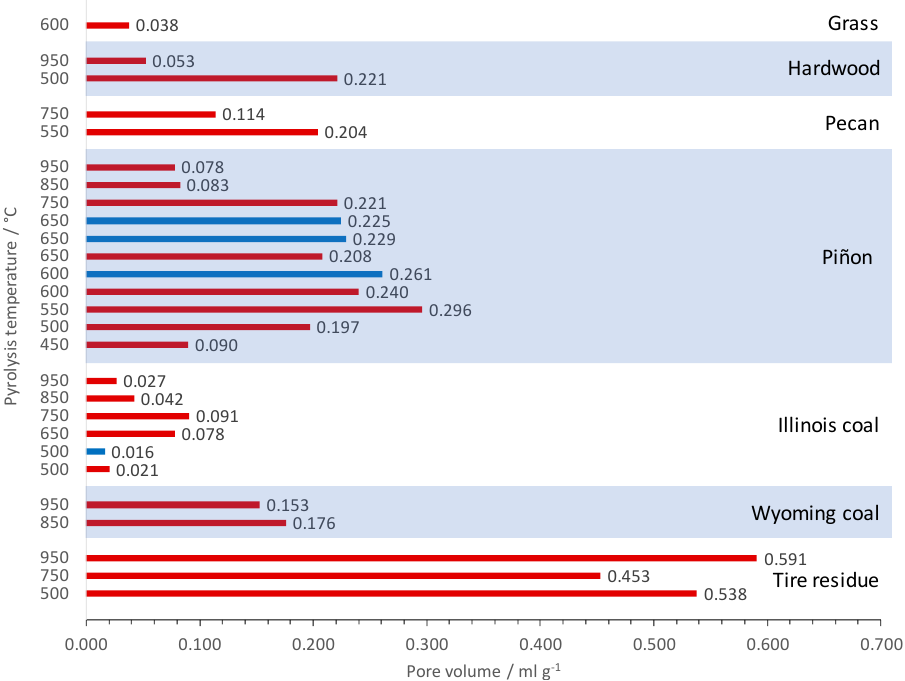
Figure 9. Summary of pore volume data for samples prepared in the tube furnace at the indicated pyrolysis temperatures under flowing nitrogen (red bars) or flowing 0.11% (vol.) oxygen in nitrogen (blue bars). All data are normalized to the mass of the activated carbon analyzed.